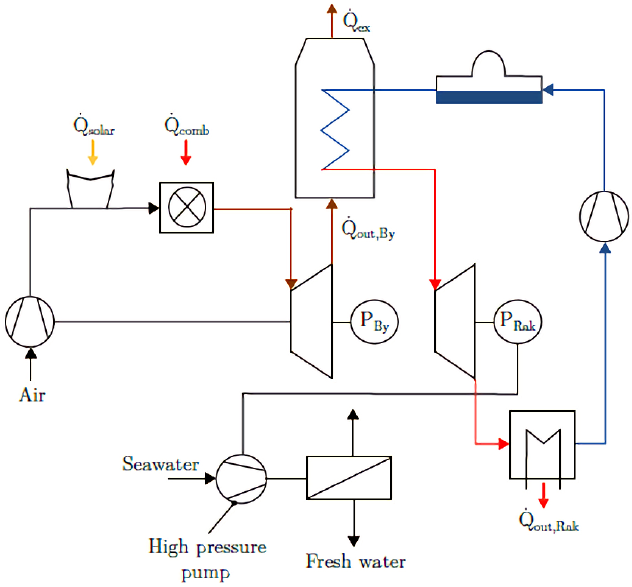
Figure 6. CRS plant powering a RO unit.